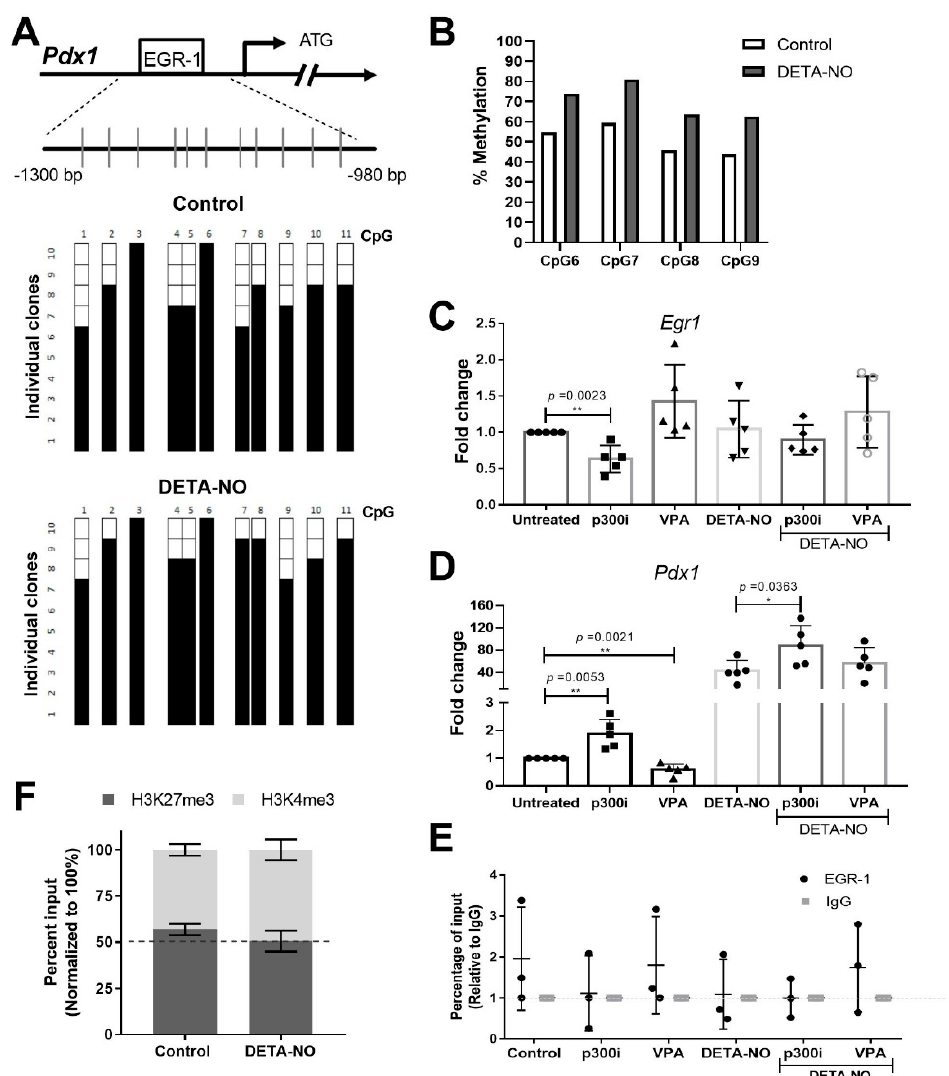
Figure 3. EGR-1 binding to Pdx1 promoter is dependent on DNA methylation and histoneP300 acetyltransferase activity. ( A , B ) Analysis of Pdx1 promoter methylation status. a) Schematic depiction of the Pdx1 promoter. Short vertical lines represent the 11 CpG dinucleotides studied. Results are shown of bisulfite PCR sequencing of 10 individual clones in control and DETA-NO conditions. Presence of a methylated (black square) or unmethylated (white square) cytosine is indicated. ( B ) Specific CpG site methylation analysis of EGR-1bs (CpG referred to as 7) and neighboring CpG sites on Pdx1 promoter, analyzed by pyrosequencing. ( C ) EGR-1 and ( D ) Pdx1 expression by real-time PCR in control cells and cells treated with DETA-NO, p300i, and valproic acid (VPA), alone or in combinations. Graph shows the average ± SD of five independent experiments. ( E ) EGR-1 binding analysis of Pdx1 promoter by chromatin immunoprecipitation (ChIP) assay. Graph shows the average ± SD of three independent experiments. Y-axis corresponds to the percentage input relative to IgG. ( F ) Stacked bars for bivalent mark dynamics of H3K27me3 and H3K4me3 analyzed by ChIP assays. They represent an average of two independent experiments. Data with * p < 0.05 or ** p < 0.01 were considered statistically significant.